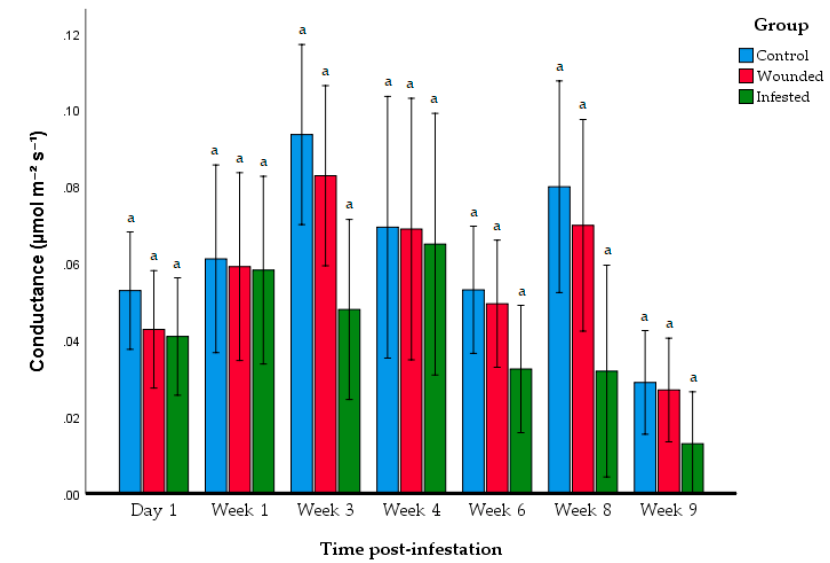
Figure 5. Stomatal conductance of each group at at di ff erent periods after infestation. Data shown as mean + S.D. Di ff erent letters indicate significant di ff erences among the control, wounded, and infested group within each time post-infestation period based on ANOVA following the Tukey multiple comparison test ( p > 0.05).